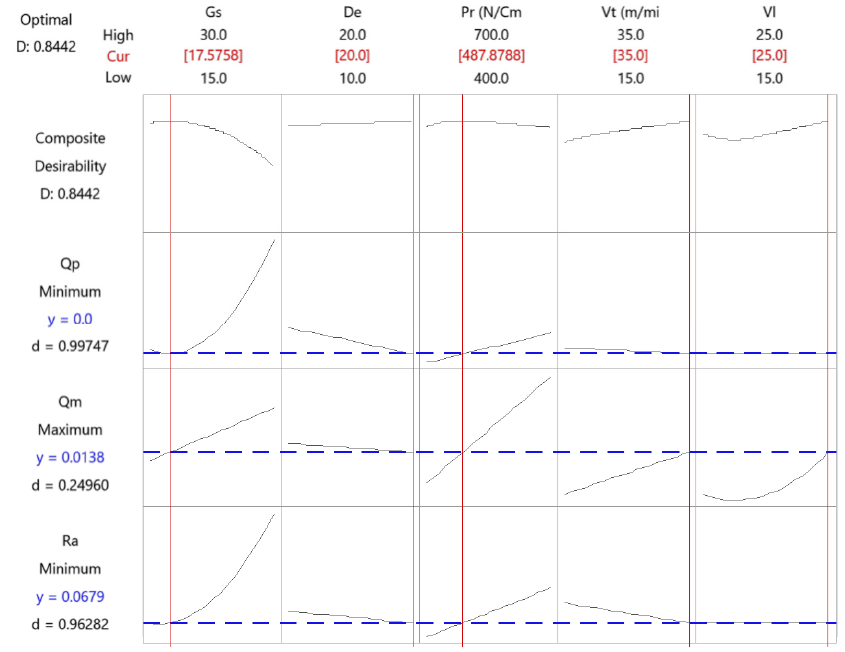
Figure 12. Multi-objective optimization of the finish honing operation.